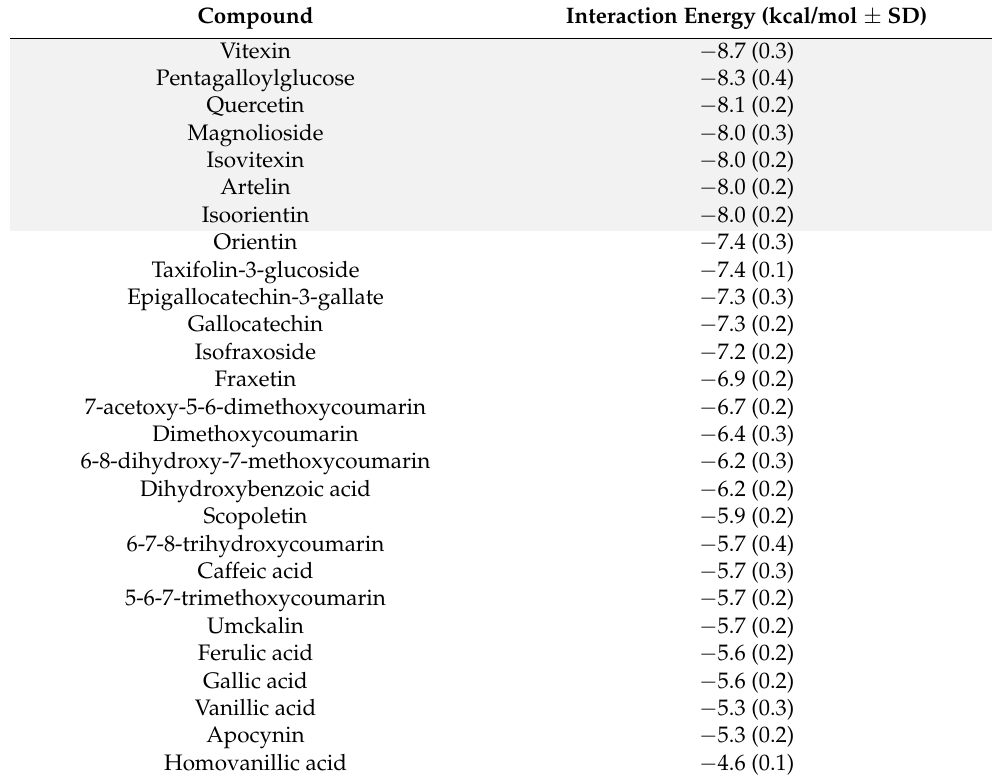
Table 3. 3CLpro molecular docking results. The average interaction energy calculated from three independent docking runs, including standard deviation, is reported for each compound.